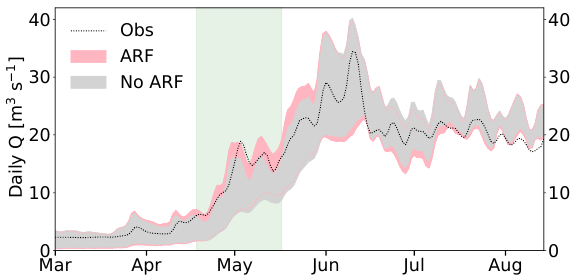
Figure 9. The 95% confidence interval of simulated discharge due to parameter uncertainty when allowing for ARF (red) and disre- garding ARF (grey), calculated using the GLUE method and aver- aged over the 6-year simulation period. The shaded box marks the period of the melt season, where observations tend to lie outside the uncertainty bounds of the no-ARF